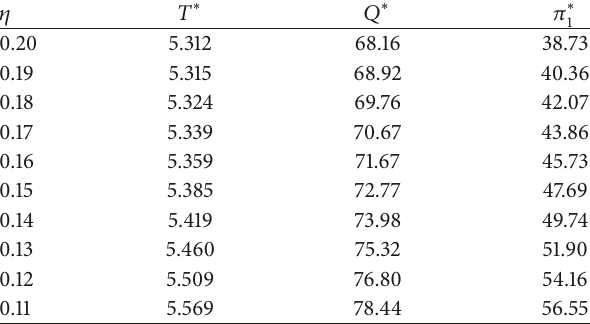
Table 3: The impact of 𝜂 on decisions of retailer.